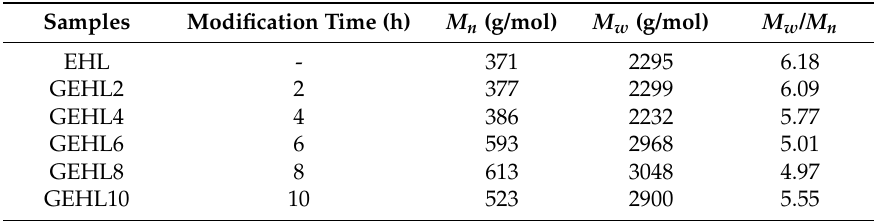
Table 5. Results of M n , M w , and polydispersity of acetylated lignin samples.